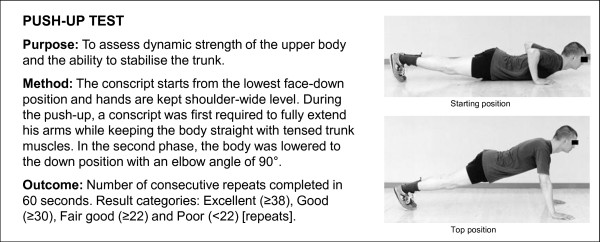
Description of push-up test. The test is based on practice in the Finnish Defence Forces.